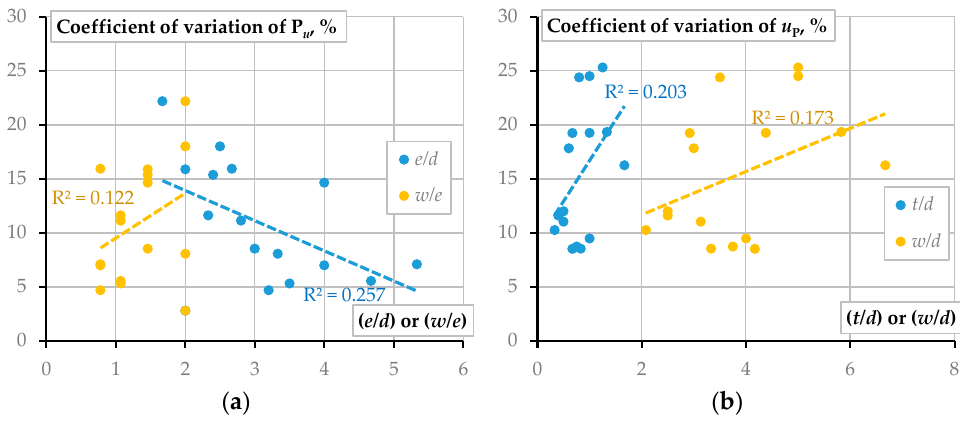
Figure 8. Variation of the test results: ( a ) Maximum load, P u ; ( b ) Deformation corresponding to P u .